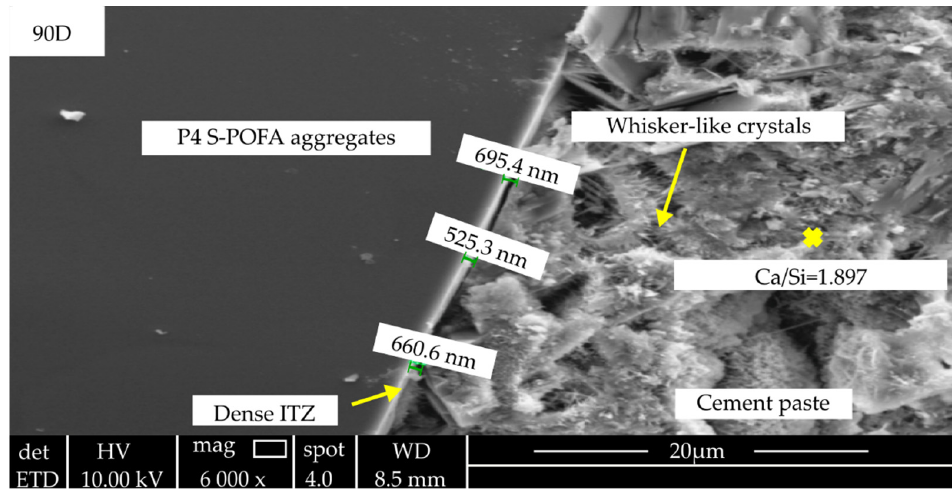
Figure 3. SEM images of S-POFA LWC ITZ (×6000) at 90 d [13]. Huang et al. (2019) [98] also claimed that there were no obvious cracks at the ITZ junction due to the tight binding between the lightweight aggregate and cement paste.